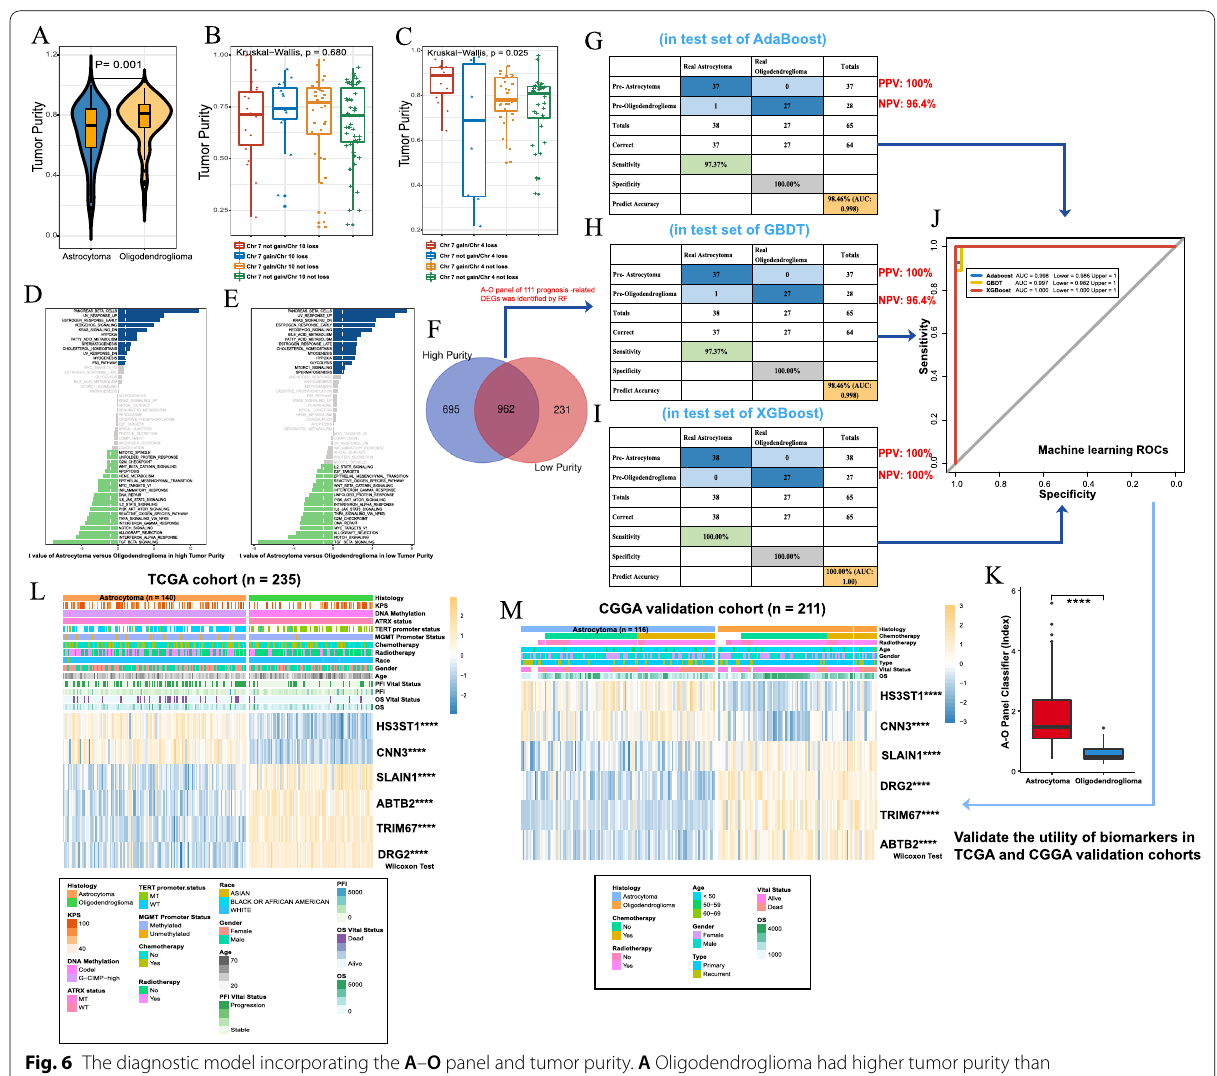
Fig. 6 The diagnostic model incorporating the A – O panel and tumor purity. A Oligodendroglioma had higher tumor purity than oligodendroglioma (Wilcoxon P 0.001). B Tumor purity among astrocytoma subtypes based on CNA status (chr 7/chr 10 status, K-W P 0.690). = = C Tumor purity among oligodendroglioma subtypes based on CNA status (chr 7/chr 4 loss, K-W P 0.025). D , E GSVA indicates variation of gene = sets enriched in high tumor purity ( D ) and low tumor purity ( E ). Blue bars, gene sets significantly enriched in astrocytoma; green bars, gene sets significantly enriched in oligodendroglioma; gray, not significant. F . 962 DEGs selected in high and low tumor purity groups. G–I Confusion matrices of binary results of the diagnostic prediction model in the test sets for AdaBoost ( G ), GBDT ( H ) and XGBoost ( I ). J . Complex ROCs of three machine learning algorithms. K Astrocytoma had significantly higher A–O Panel Classifier (Index) than oligodendroglioma (Wilcoxon ****P < 0.0001). L Validation of the 6 important biomarkers of the A–O panel in the TCGA cohort. M Validation of the 6 important biomarkers of the A–O panel in